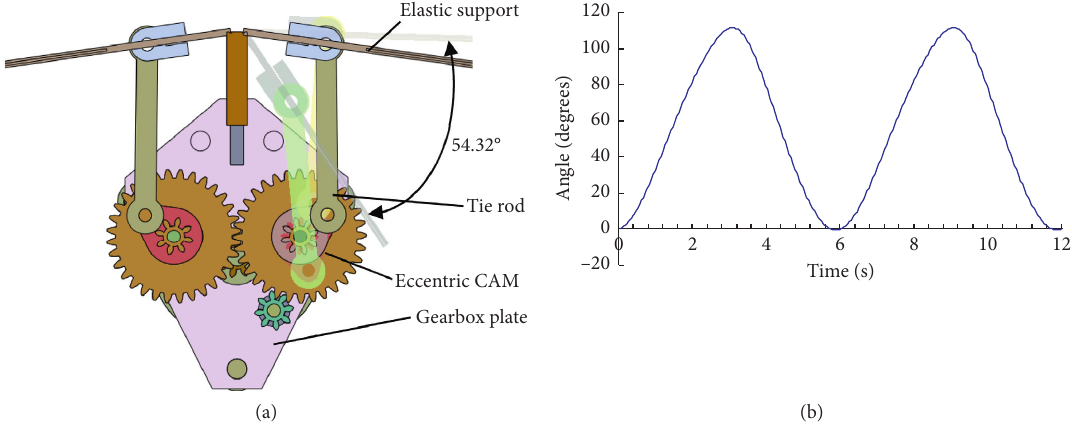
Figure 8: (a) Crank rocker mechanism and (b) the curve of the angle between the upper and lower wings with time when the wings are flapped up and down after